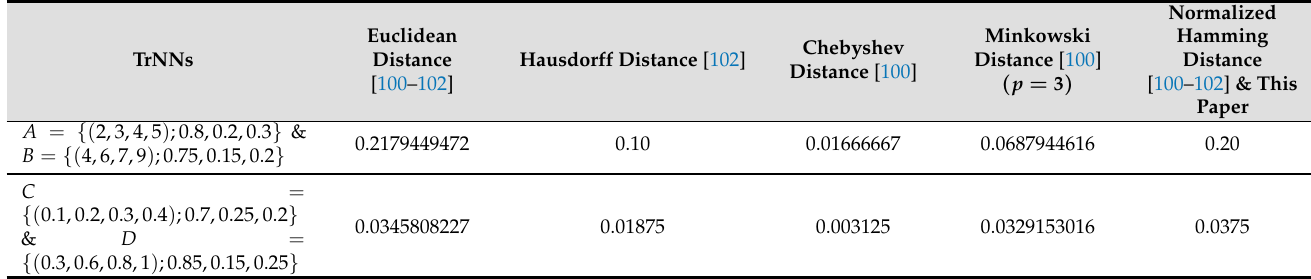
Table 5. Distance between two TrNNs by different distance measuring